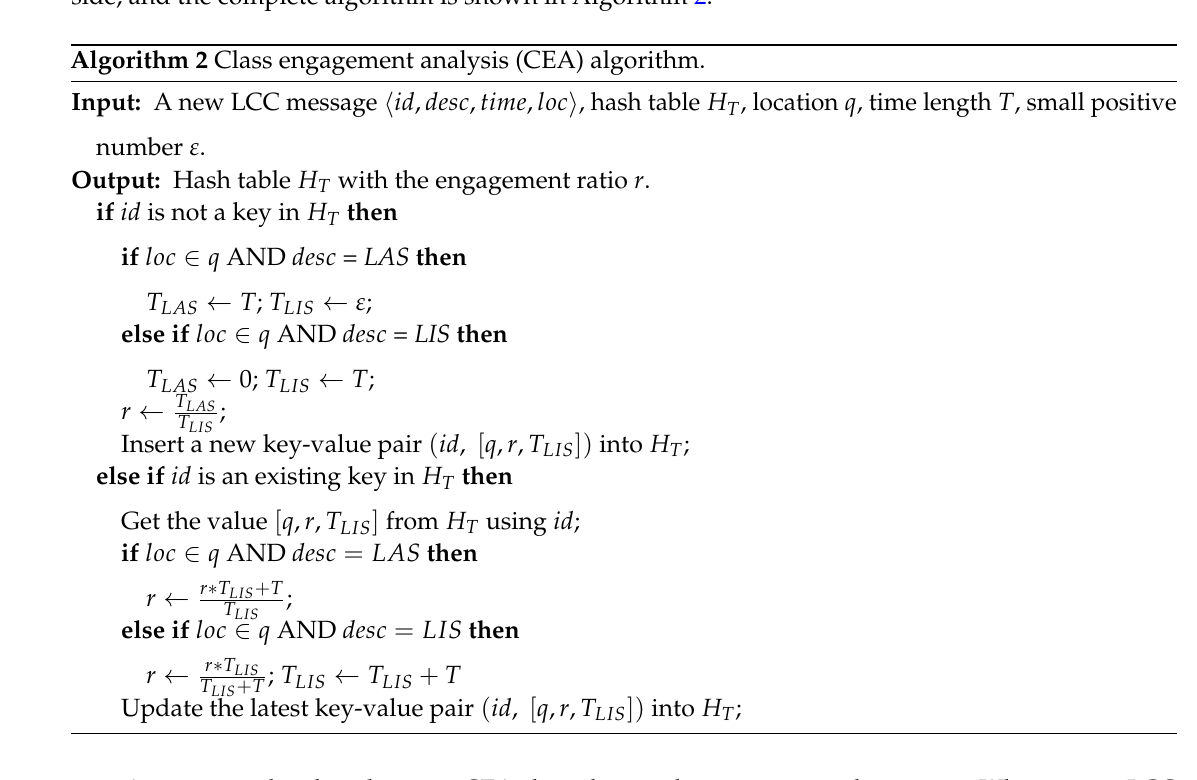
Algorithm 2 Class engagement analysis (CEA)